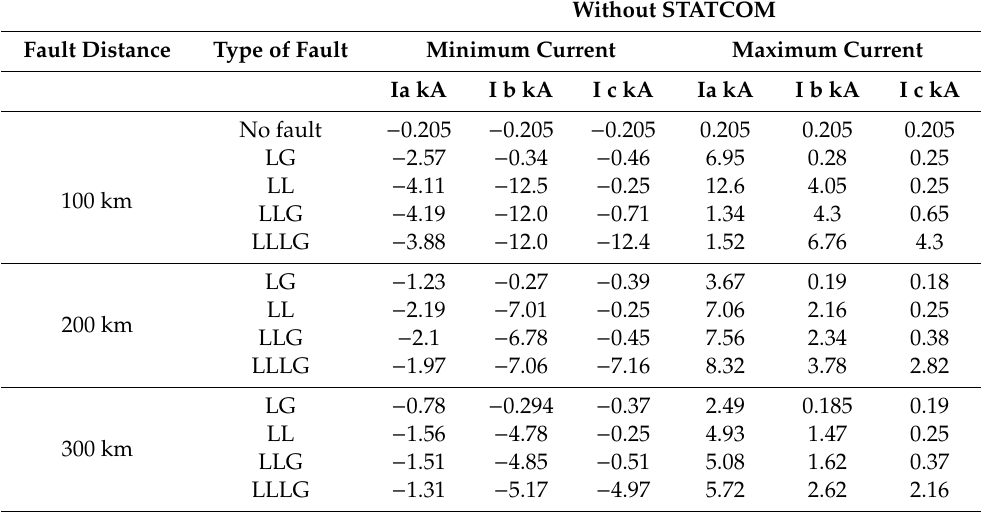
Table 3. Current magnitude during normal conditions and faults at di ff erent locations without the STATCOM-compensation.